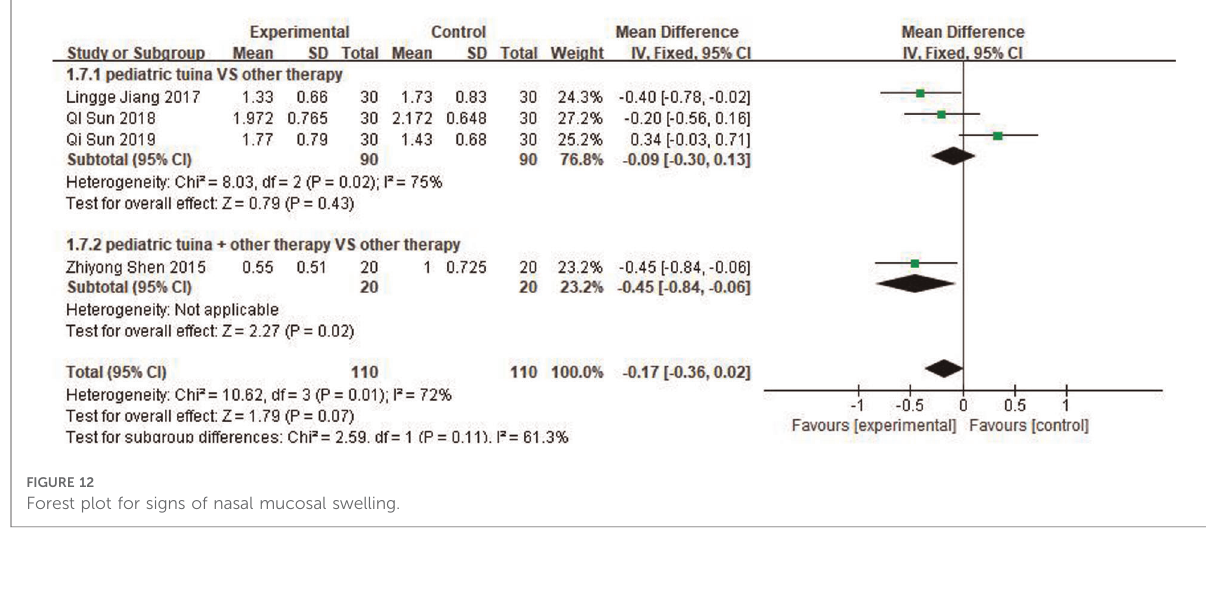
FIGURE 12 Forest plot for signs of nasal mucosal swelling.